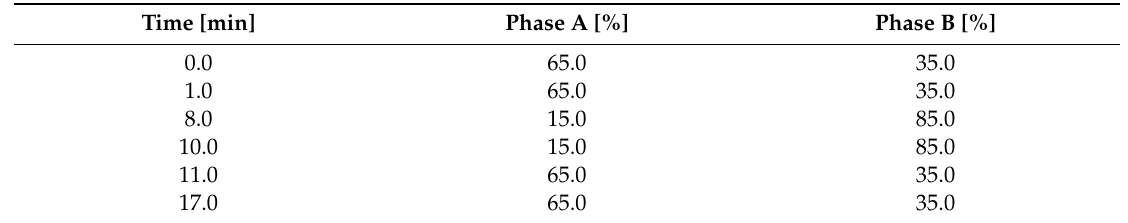
Table 5. The composition of the mobile phase in the time intervals of the gradient elution used in the HPLC-MS / MS